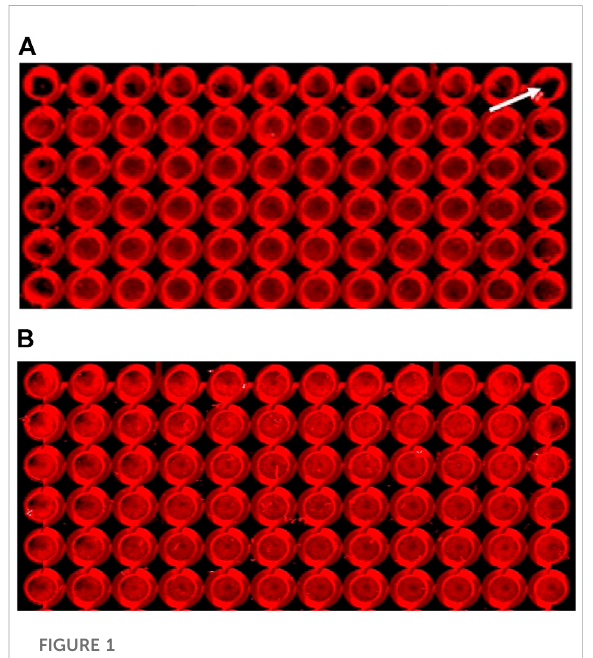
FIGURE 1 Cells pre-incubated at room temperature for 30 min displayed a reduced edge-effect. Cells were assayed as described in the Methods section, using SNC80 (1 µM) to activate DOPr. Images of 96-well plates seeded with 25,000 cells per well wereplacedeither (A) immediatelyintoa37 ° Cincubator(thewhite arrow indicates a peripheral well with a marked edge effect), or (B) pre-incubated for 30 min at room temperature (22 ± 1 ° C), prior to incubation at 37 ° C. Images show cells cultured for 24 h, fi xed, permeabilized, blocked, and labeled with primary (ERK1/2) and secondary (IRDye ® ) antibodies. The images were scanned using the LI-COR Odyssey ® system (Image Studio). Effect of DOPr agonists on ERK activation time-course.